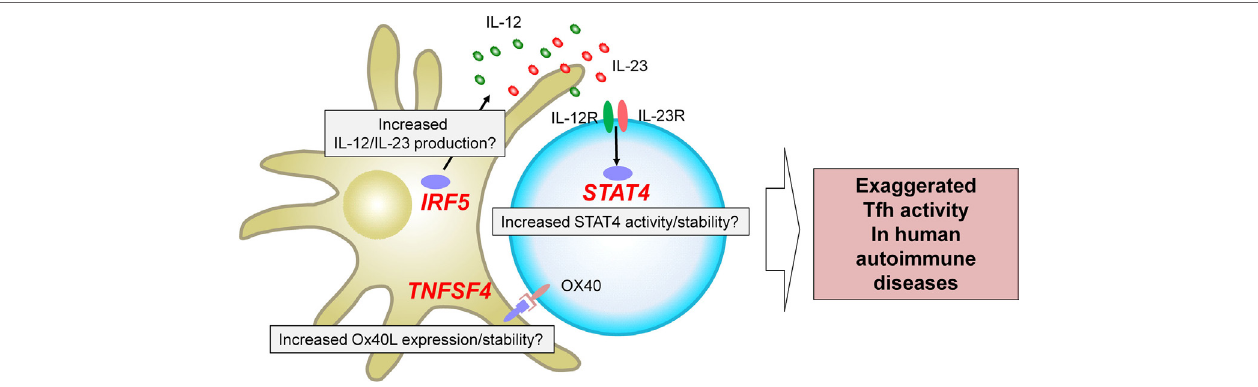
FigURe 2 | Three risk loci potentially associated with exaggerated T follicular helper (Tfh) response in human autoantibody-mediated autoimmune diseases. GWAS in autoimmune diseases have identified multiple loci associated with disease risk. STAT4 , IRF5 , and TNFSF4 have been identified and validated in multiple studies on autoantibody mediated autoimmune diseases as risk loci with a strong disease association at the genome-wide p value of at least 5 × 10 − 8 . These risk loci might contribute to the exaggerated Tfh response in human autoimmune diseases. For example, IRF5 risk loci might be associated with an increased production of Tfh-promoting cytokines, including IL-12, IL-23, and IL-6. TNFSF4 risk loci might contribute to increased Ox40 signals that promote the expression of Tfh molecules by human CD4 + T cells. STAT4 risk loci might affect the activity and/or stability of STAT4 and might enhance the signals of IL-12 and